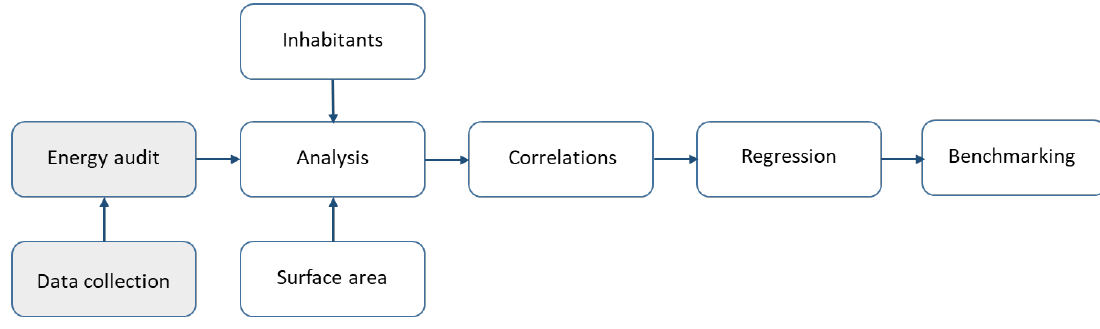
Figure 1. Methodology diagram .